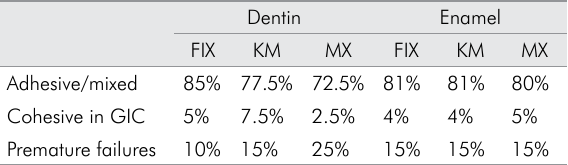
Table 3. Percentage of the failure modes according to GIC and substrate.